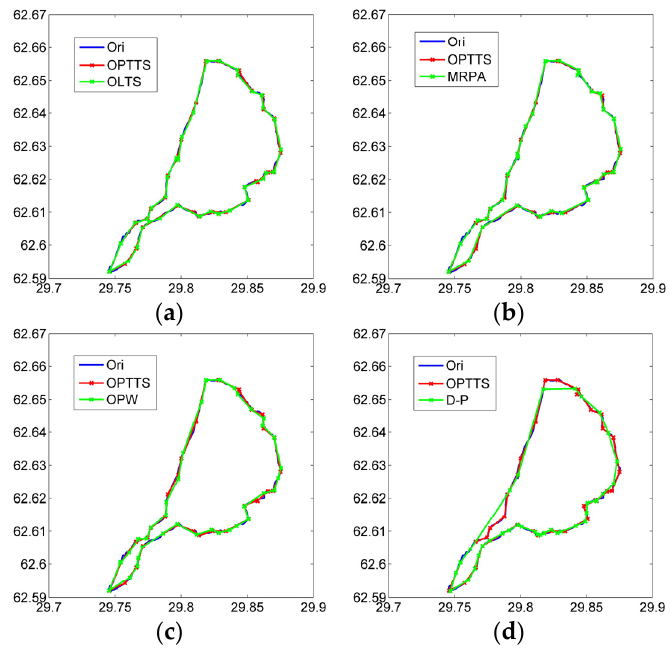
Figure 15. Visualization of compressed trajectories by different algorithms. ( a ) OPTTS vs. OLTS. ( b ) OPTTS vs. MRPA. ( c ) OPTTS vs. OPW. ( d ) OPTTS vs. D-P.5.3. Evaluation Based on Time Cost.